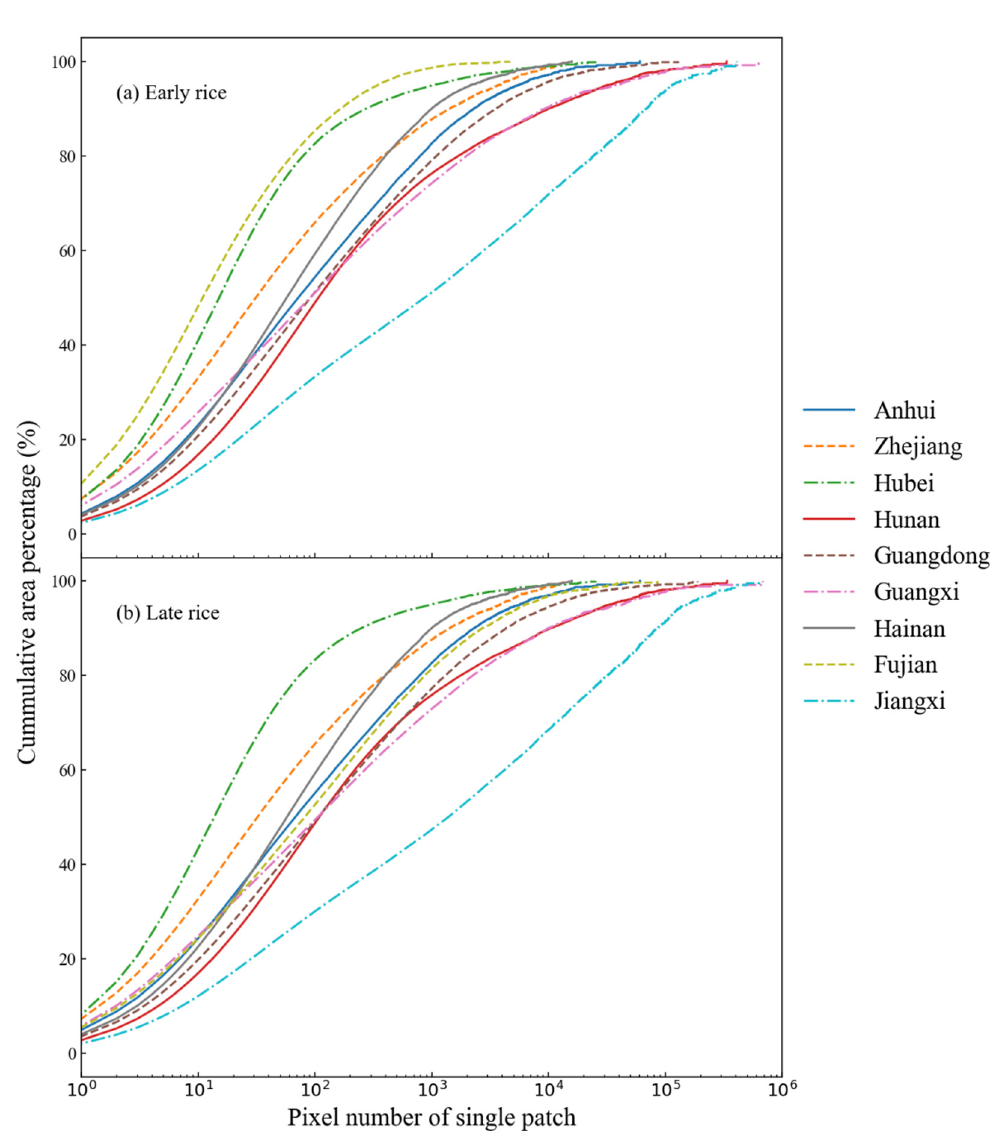
Figure 9. Statistics for patches with different pixel numbers in the distribution map of early rice ( a ) and late rice ( b ) in 2018.